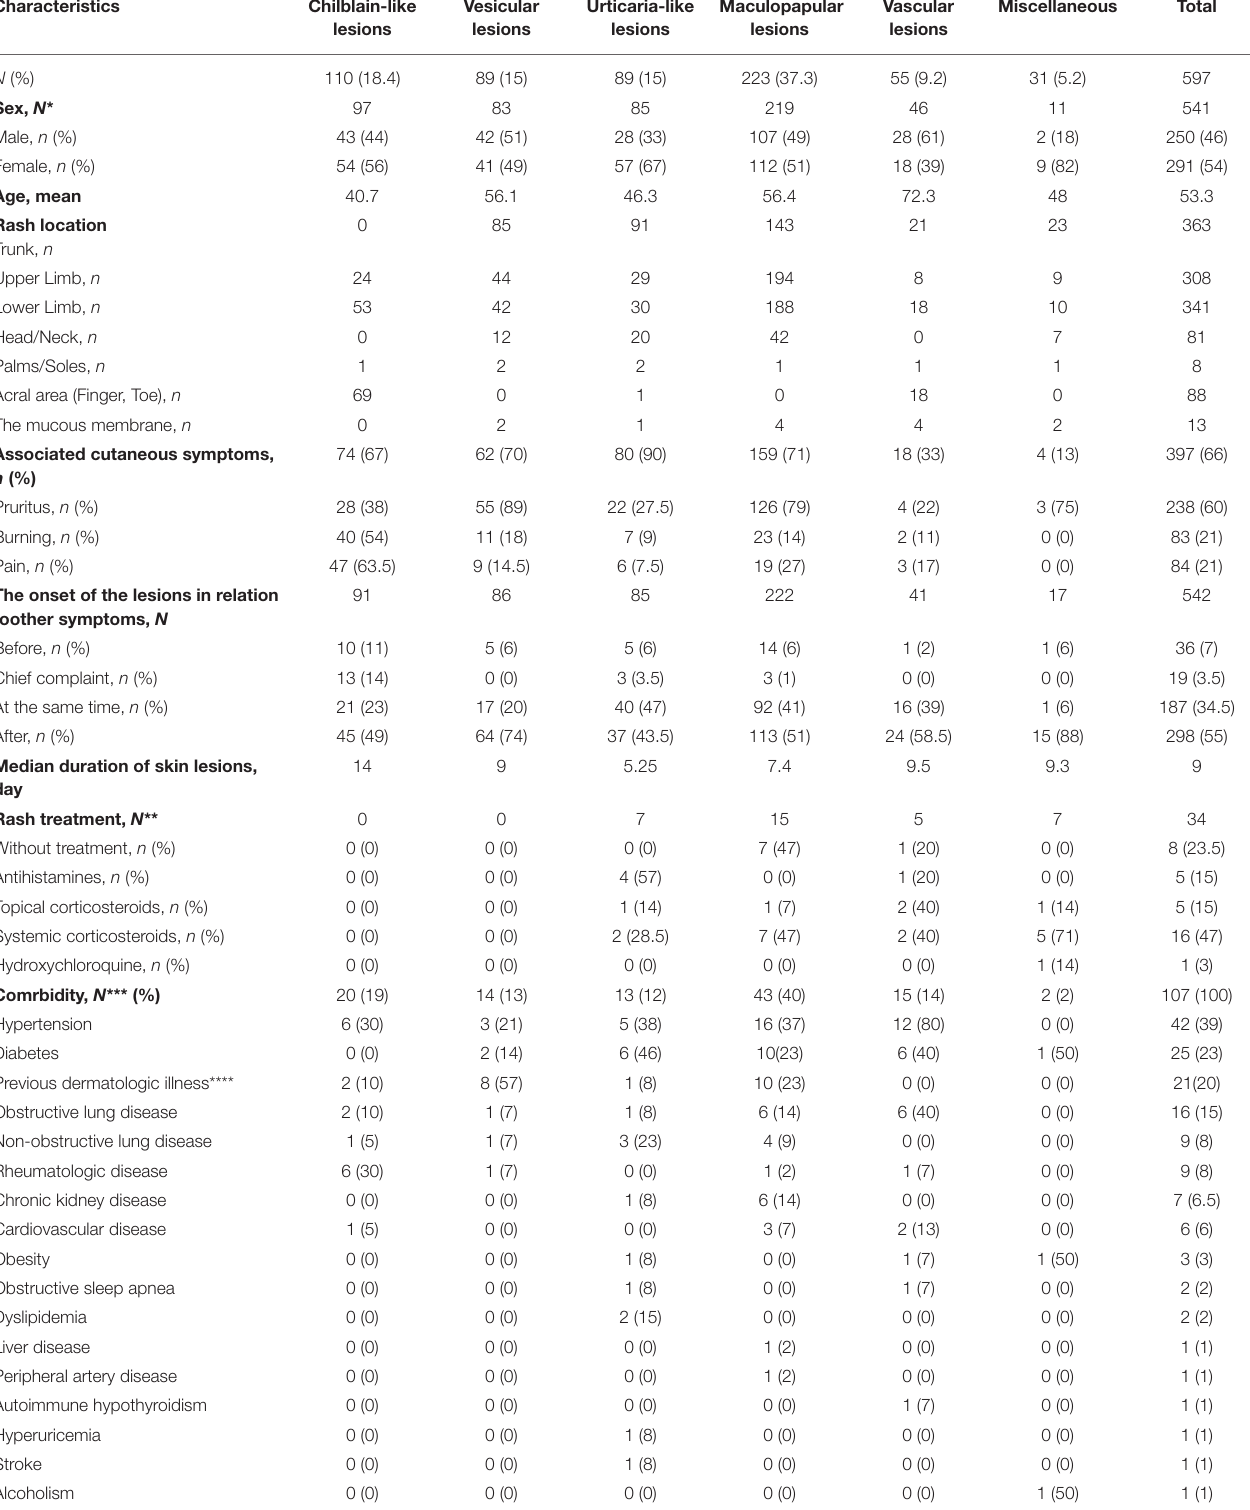
TABLE 4 | Summary of characteristics of the patients based on the type of lesions. Characteristics Chilblain-like